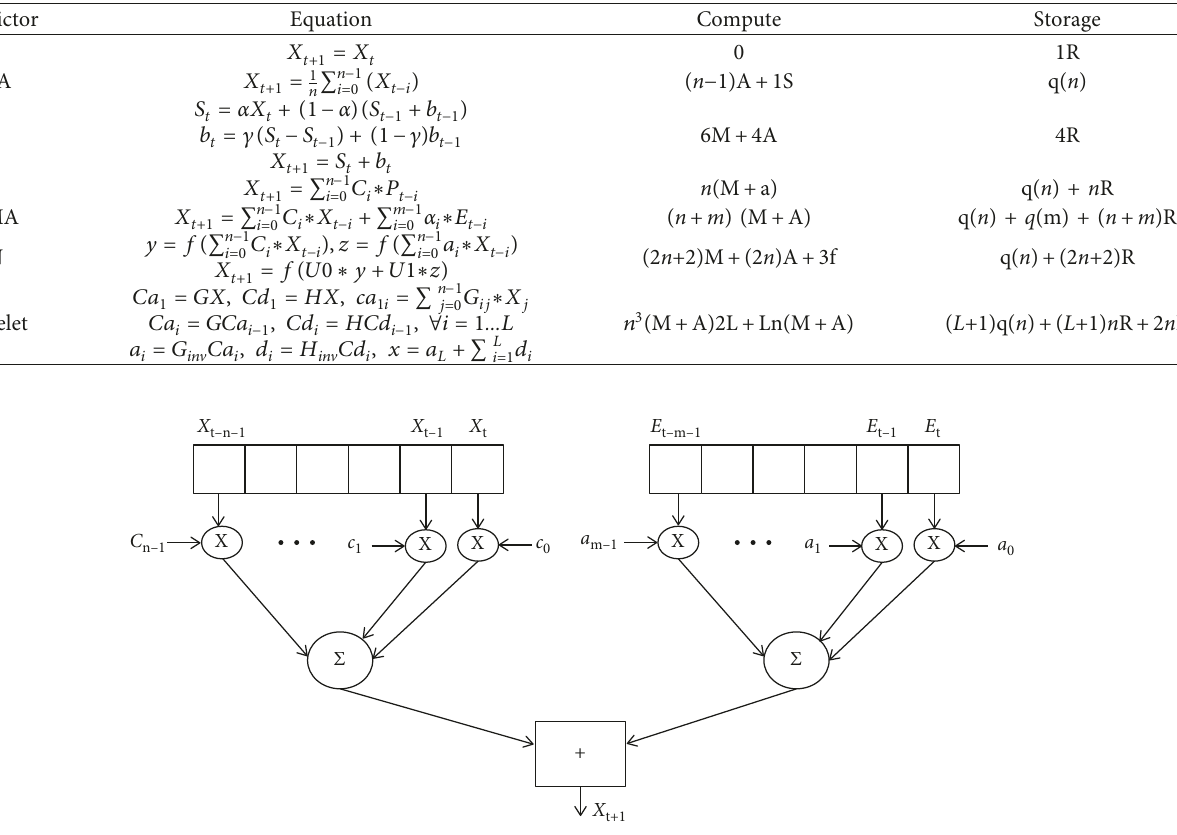
Figure 1: Block diagram of an ARMA predictor.